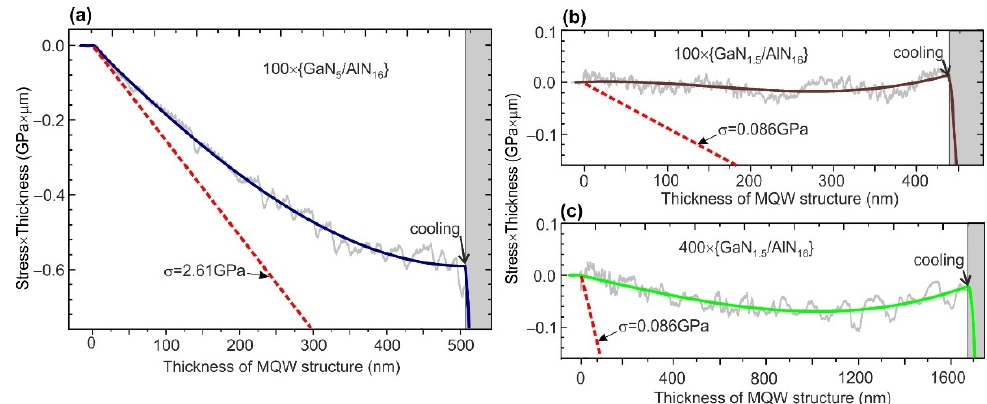
Figure 4. Evolutions of the products (stress × thickness) during the PA MBE of ML-thick N × {GaN m /AlN n } MQW structures with: ( a ) m = 5 ML, n = 16 ML, and N = 100; ( b ) m = 1.5 ML, n = 16 ML, and N = 100; ( c ) m = 1.5 ML, n = 16 ML, and N = 400. The dashed red lines in all plots show the calculated product (stress × thickness) with (cid:104) σ c (cid:105) determined for the coherent growth of the studied heterostructures Al (cid:104) x (cid:105) Ga 1 −(cid:104) x (cid:105) N/AlN, where (cid:104) x (cid:105) = m / ( m + n )